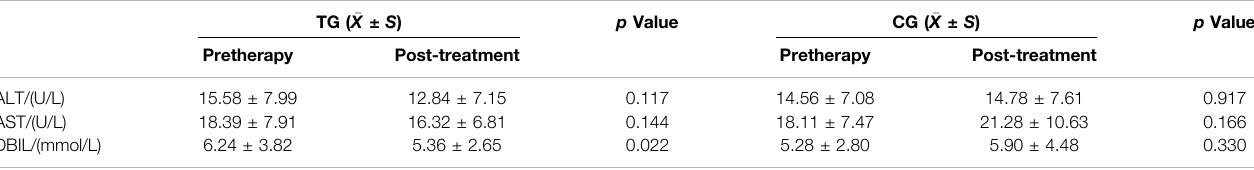
TABLE 6 | Comparison of liver function between the two groups before and after treatment. TG ( (cid:1) X ± S ) p Value CG ( (cid:1) X ± S ) p